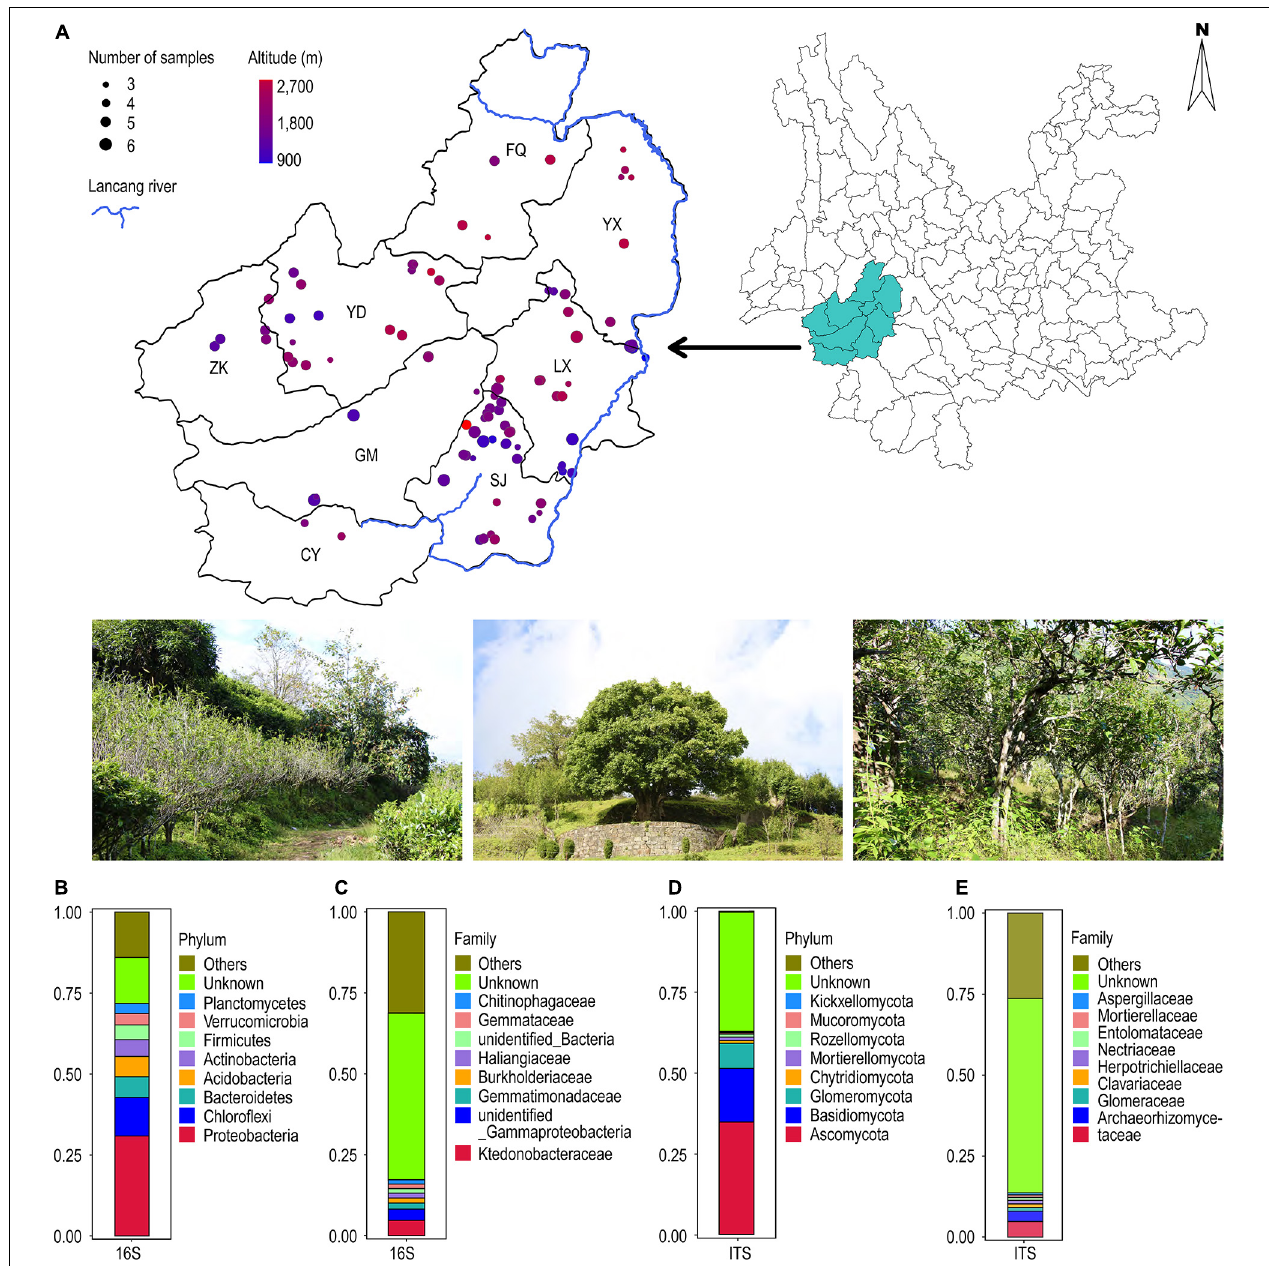
FIGURE 1 | (A) Geographical distribution of 101 ancient tea plantations in Lincang city. (B–E) Annotation of all soil sample OTUs at the bacterial and fungal phylum and family classification level. (B) 16S (first 10 bacterial phylum); (C) 16S (first 10 bacterial family); (D) ITS (first 10 bacterial phylum); (E) ITS (first 10 bacterial family).